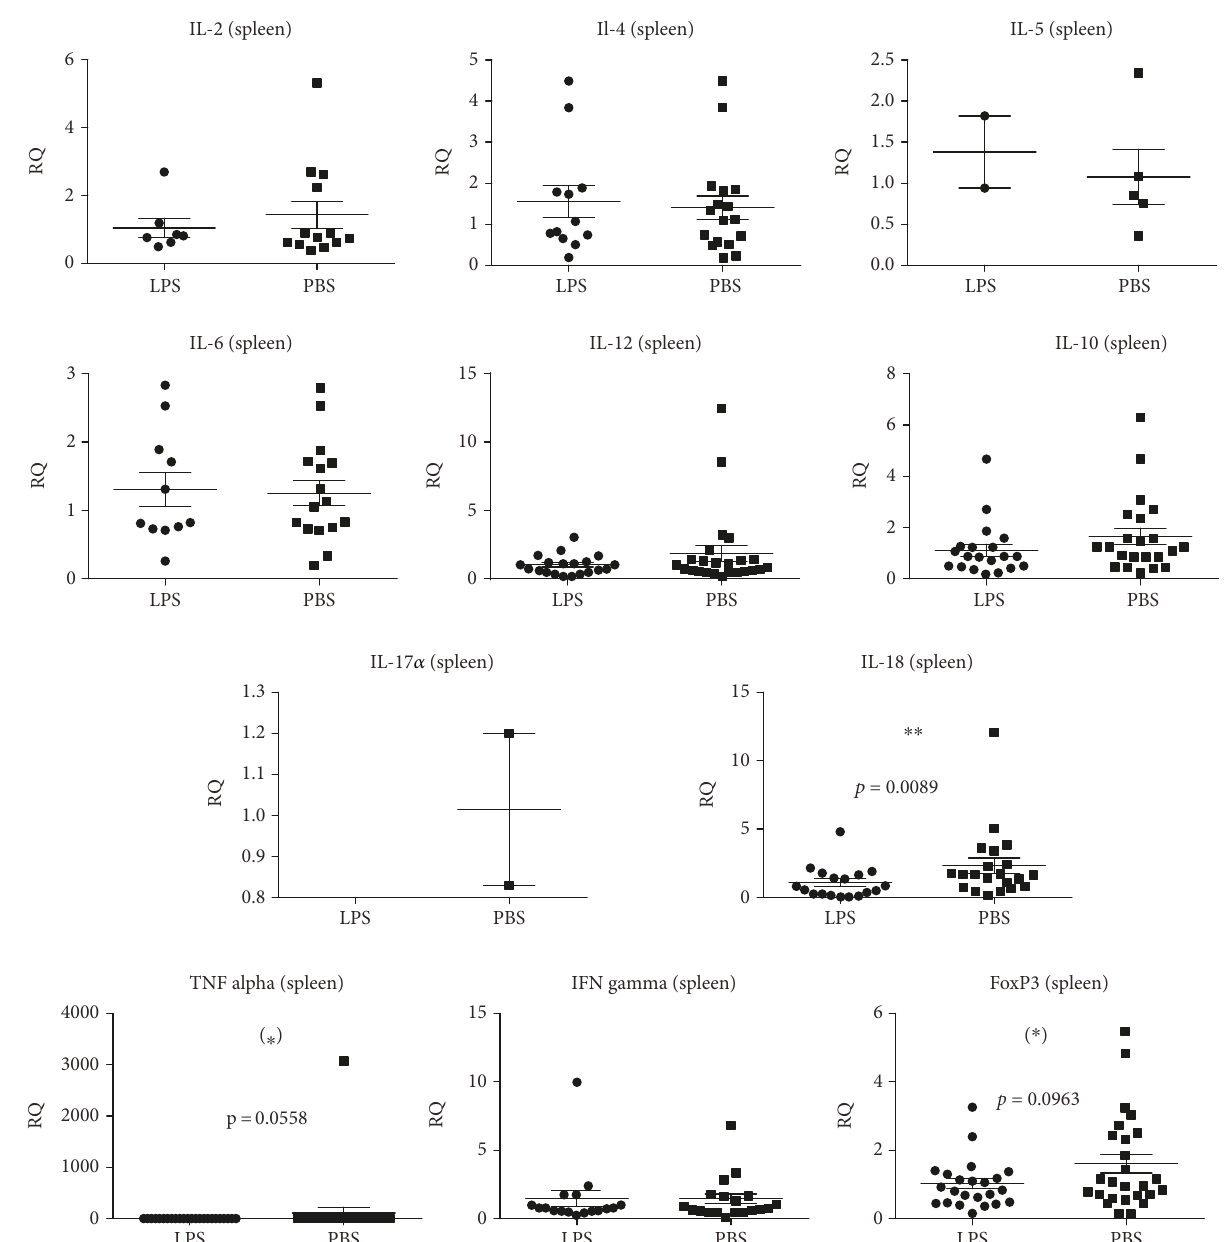
Figure 2: Cytokine and regulatory T cell ( FoxP3 ) gene expressions in the spleen of 40 (18 female and 22 male) four-week-old C57BL/6NTac mice given either LPS ( n = 18 ) or PBS ( n = 22 ) orally daily from birth until weaning at four weeks of age. Mean and SD are shown. ∗∗ p < 0 01 ; ∗ tendency p = 0 05 – 0 1